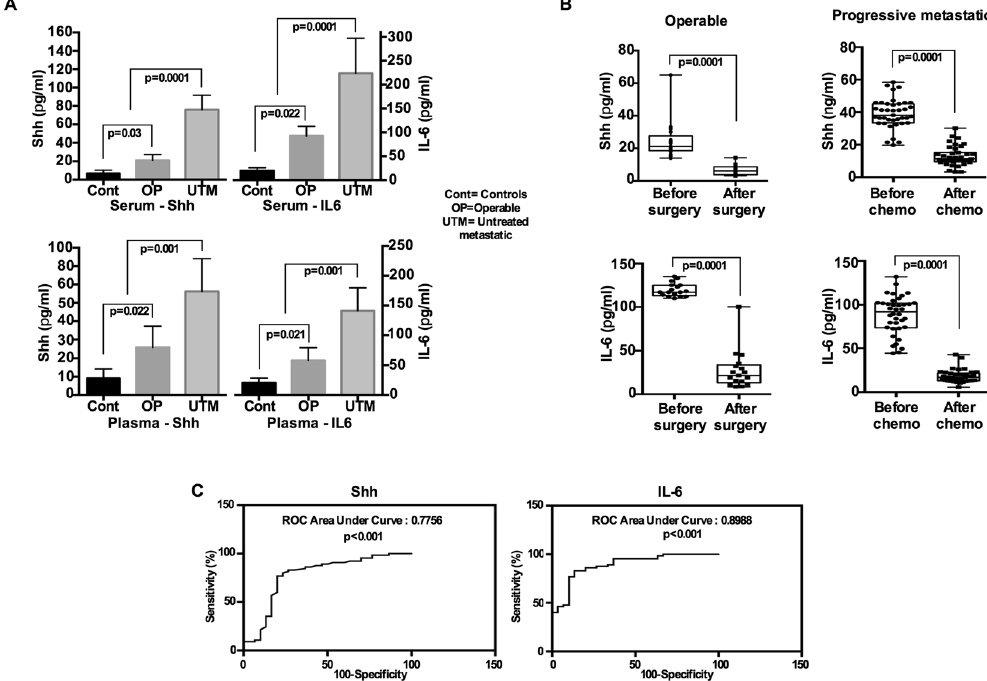
Figure 2. Serum Shh and IL-6 significantly differ between normal and cancer patients. ( A ) Serum and plasma Shh and IL-6 levels from healthy volunteers, early operable and untreated progressive metastatic breast cancer patients. ( B ) Serum Shh and IL-6 levels from early operable patients before and after surgery, as well as before and after chemotherapy from untreated progressive metastatic patients. ( C ) ROC curves of serum Shh and IL-6 as predictors in progressive metastatic breast cancer